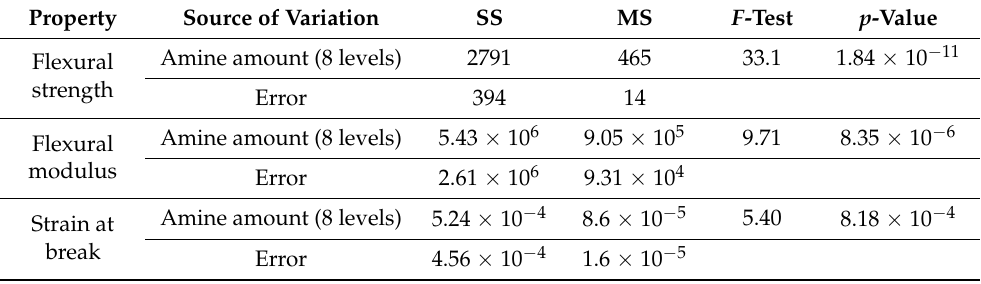
Table 7. ANOVA parameters—effect of the amount of amine on the mechanical properties. Property